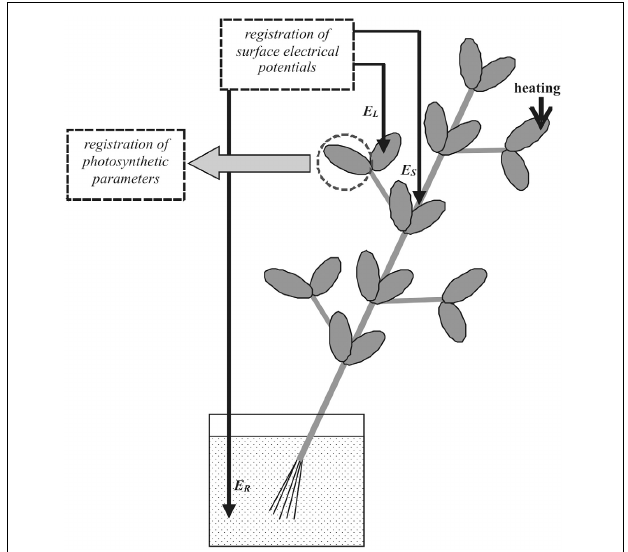
FIGURE 1 | Positions of stimulation, electrical potential, and photosynthetic parameter measurements in pea plants. E L , electrode connected to leaf; E S , electrode connected to stem; and E R , reference electrode; distance between E L and E S , 3–5cm; and heating of leaf tip (arrow) used as external